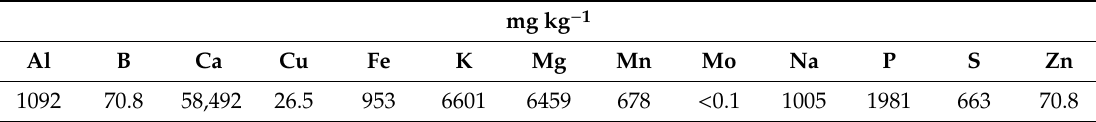
Table 2. Elemental composition of